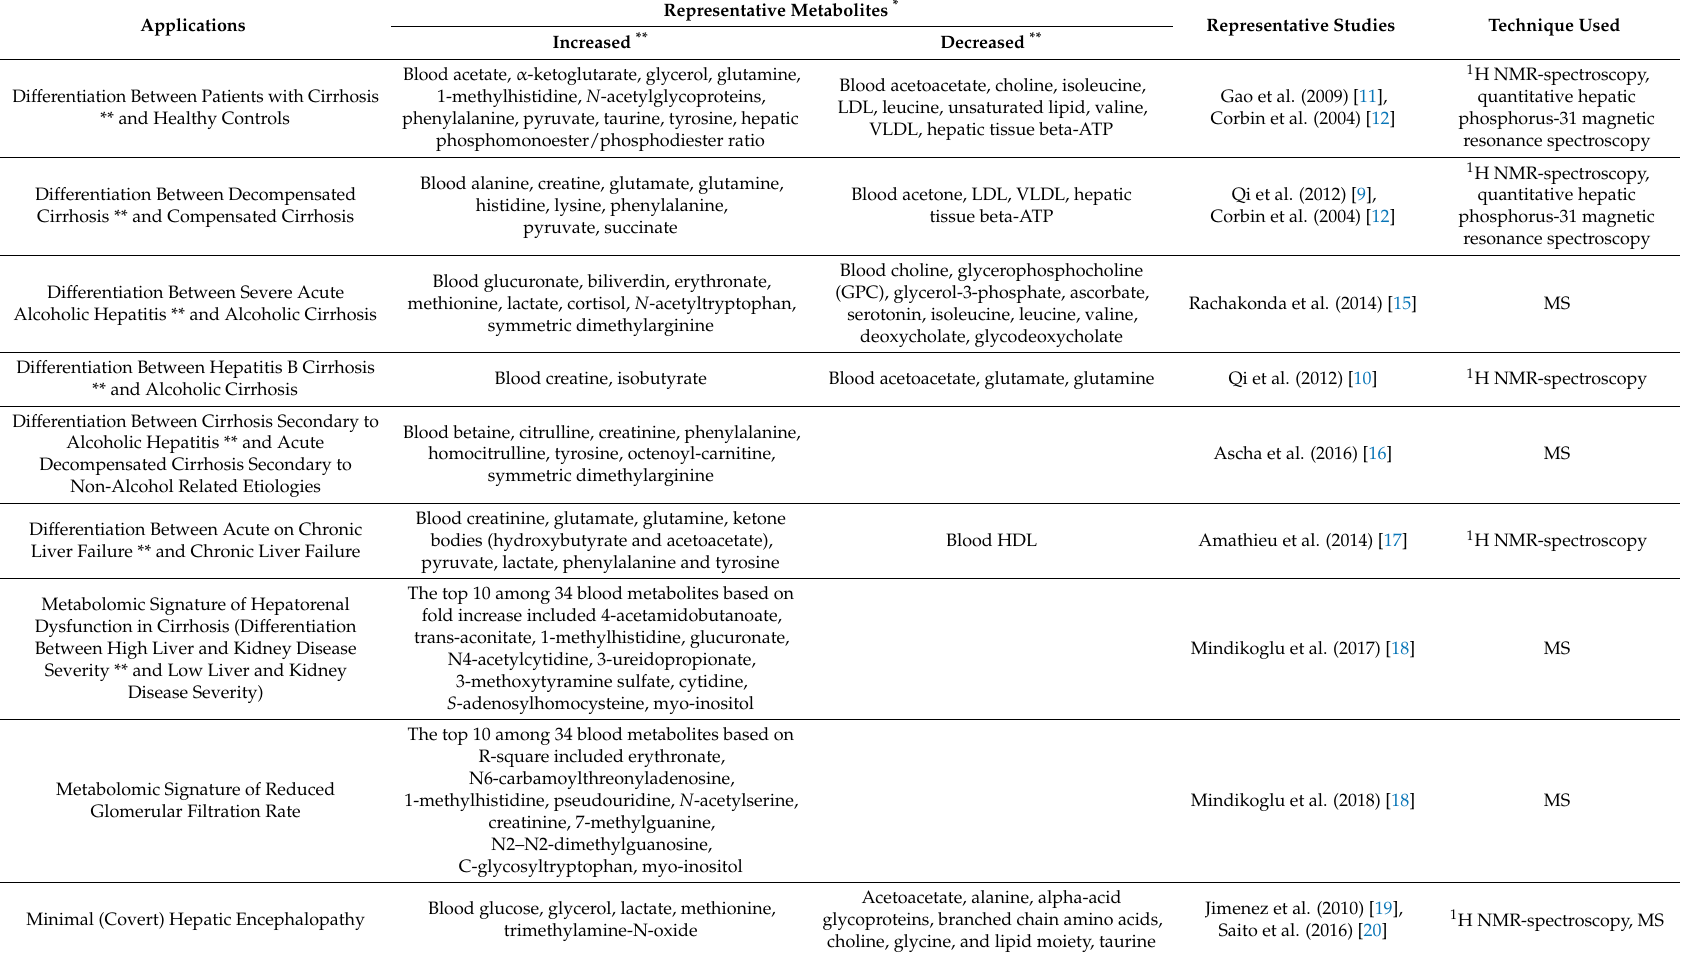
Table 2. Current applications of metabolomics in patients with